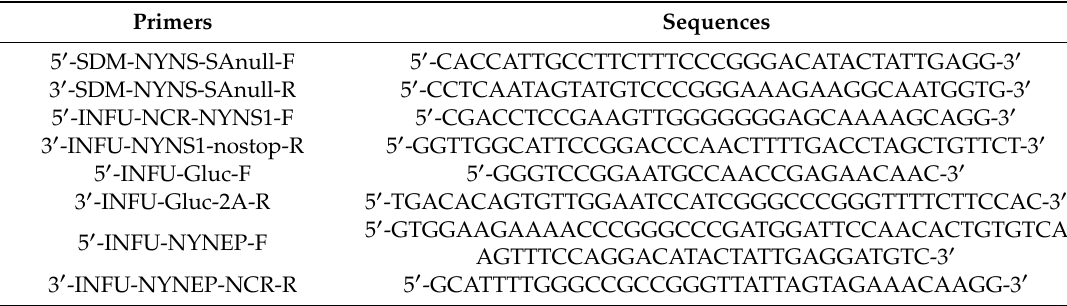
Table 1. Primers used to construct pDZ-NY /